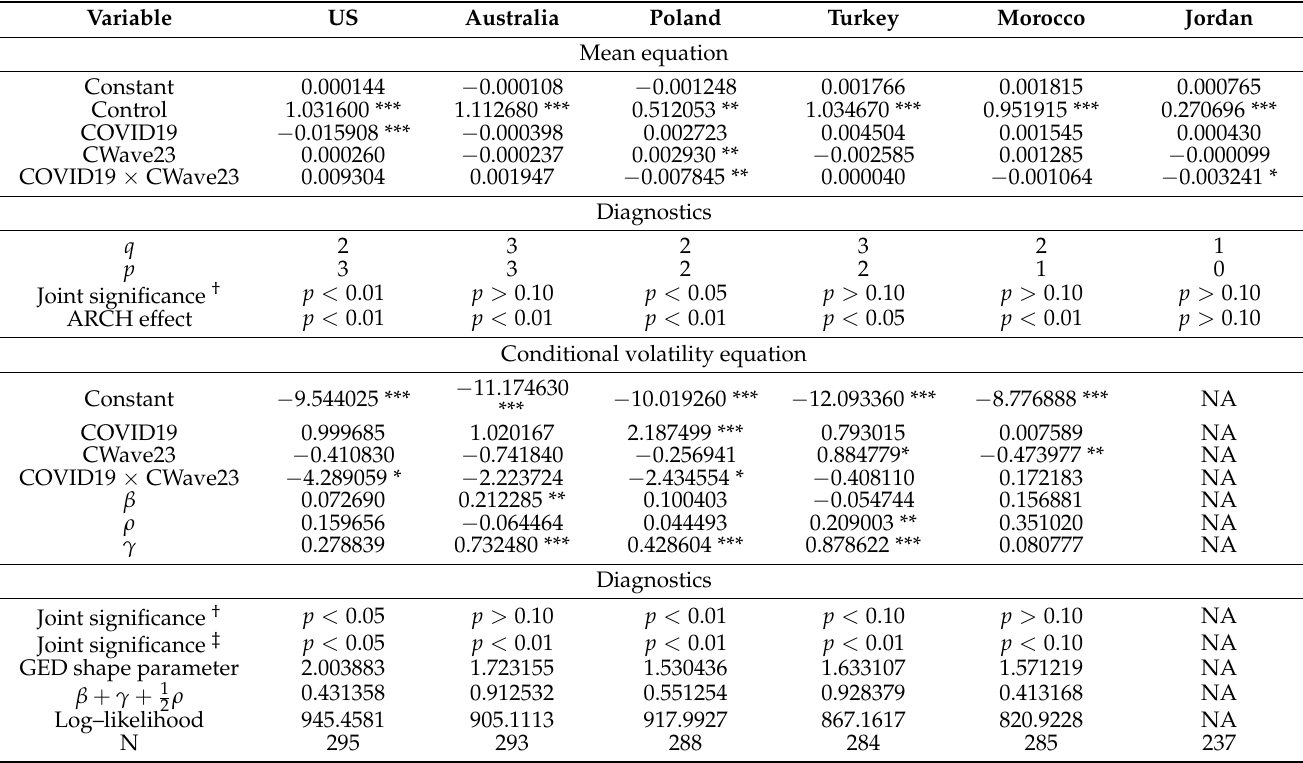
Table 2. Estimates of GJR-GARCH